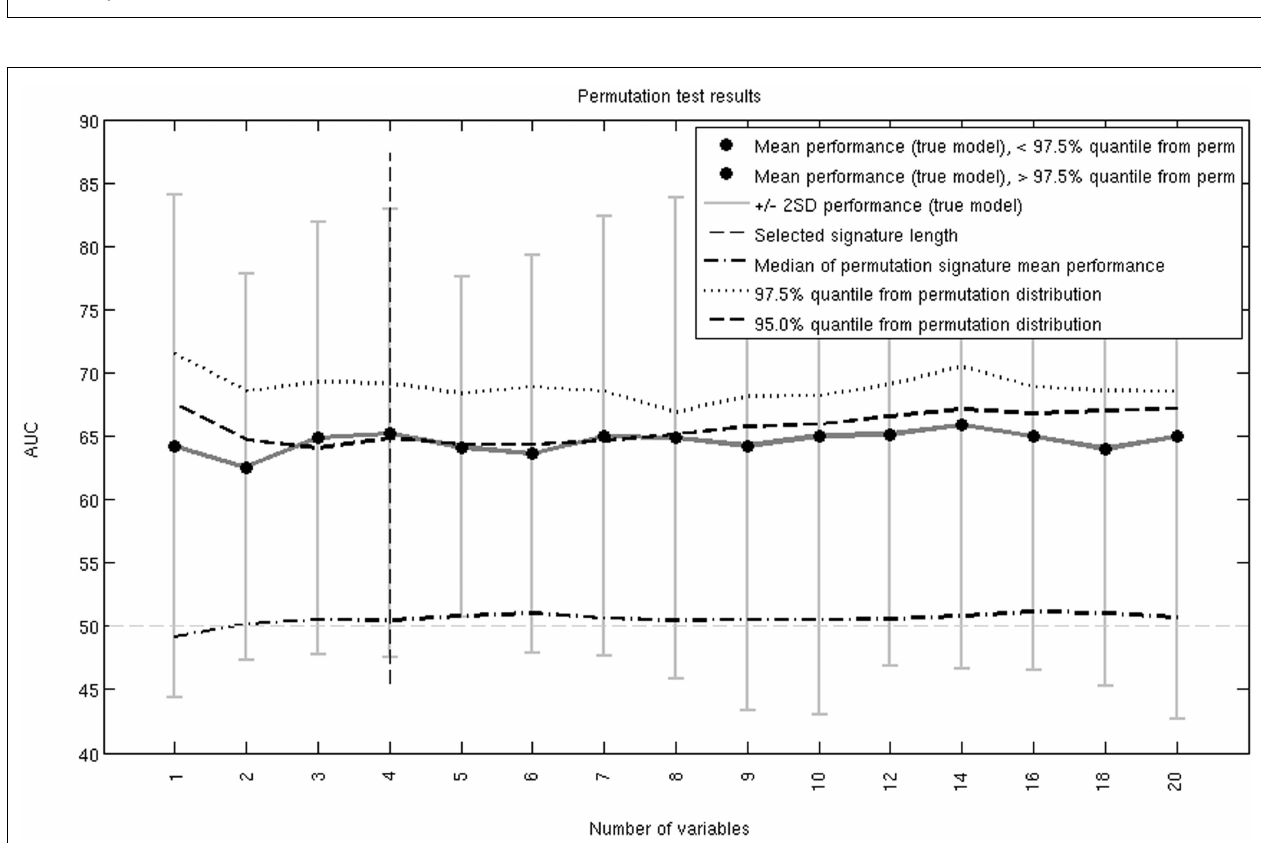
FIGURE 2 | Permutation testAUC results over all considered signature lengths .The 4-probe set genetic signature is indicated with the vertical dashed line. The true AUC curve is just above the 95% but below the 97.5% quantile.